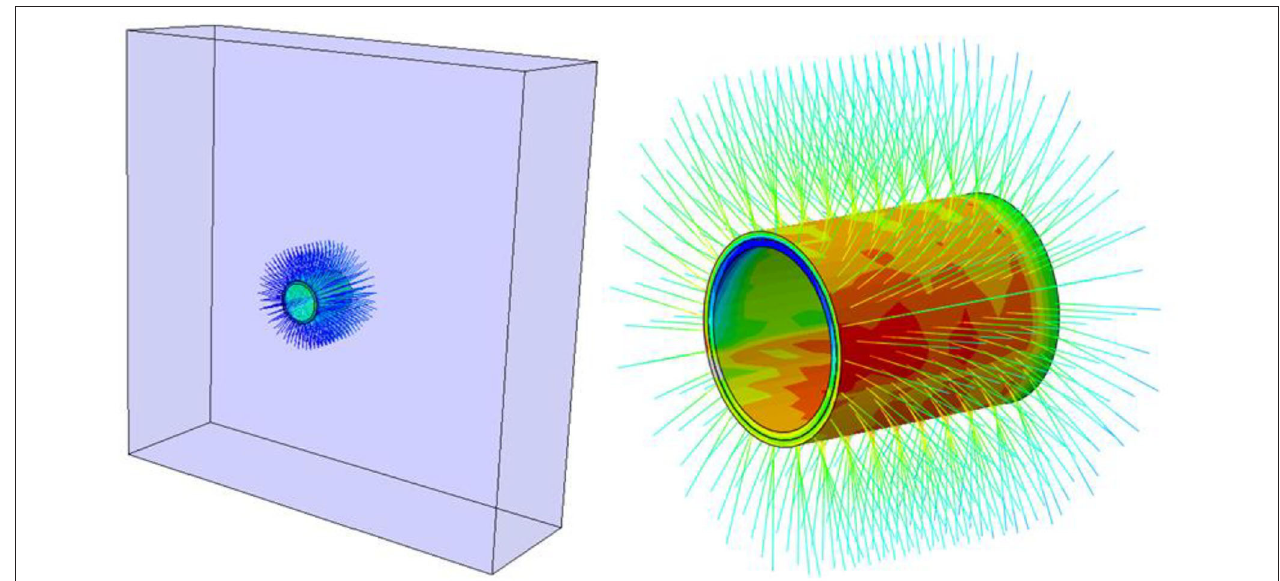
FIGURE 8 | The seventh construction step: the planned surrounding rock excavation completion and support structure construction.